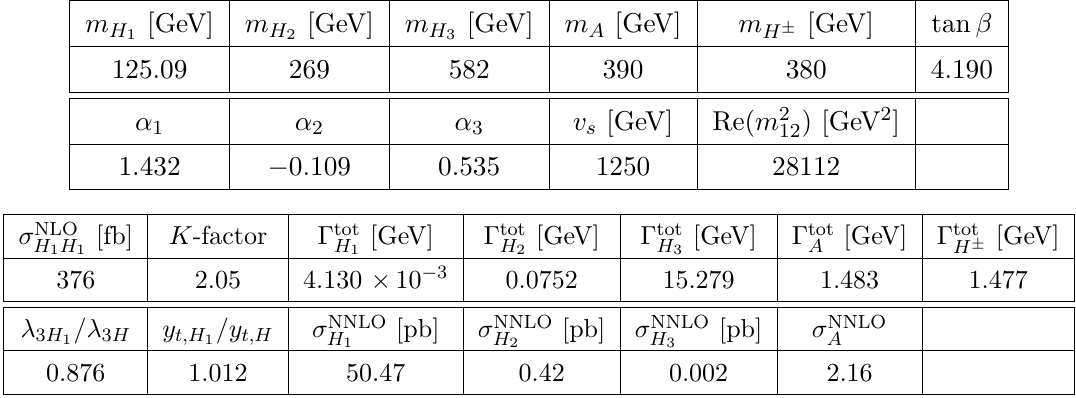
Table 13 . BP6 Upper: N2HDM-I input parameters. Lower: additional double and single Higgs production related